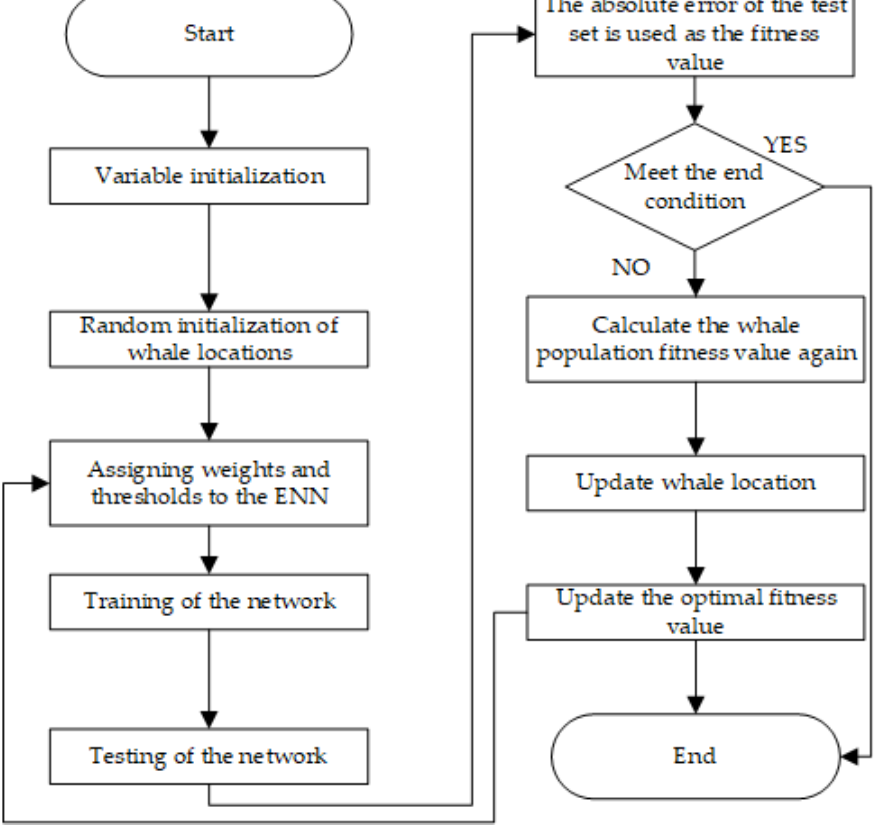
Figure 6. The operation flow of the WOA-ENN model.